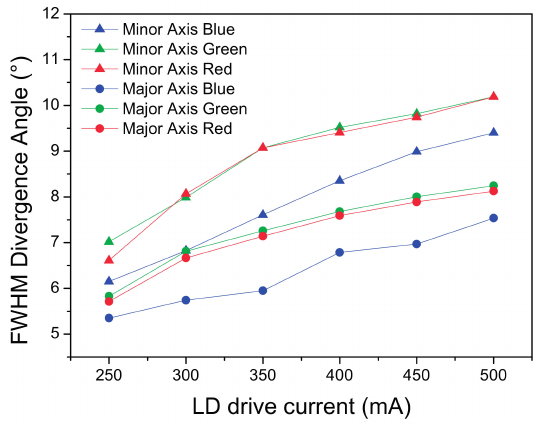
Figure 20. RGB FWHM divergence angle analysis for the reflective LARP setup nr. 2.